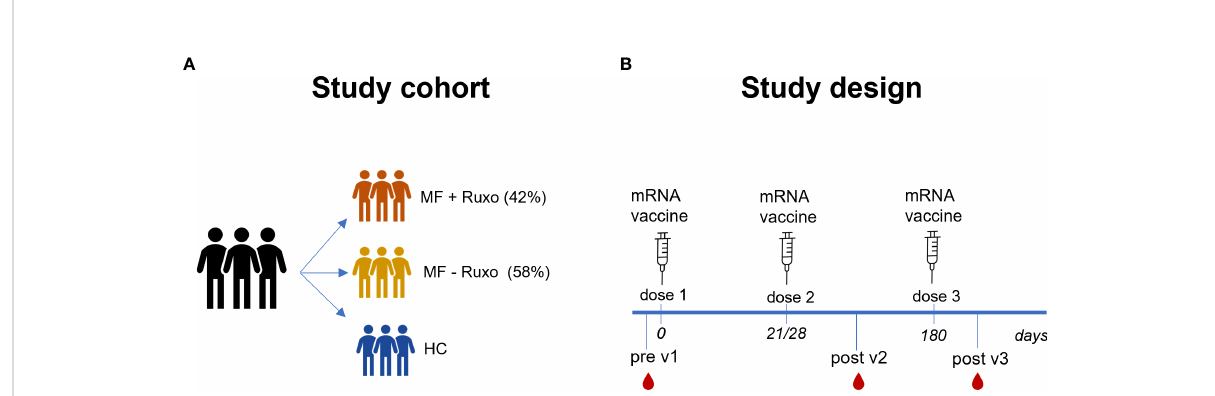
FIGURE 1 Schematic representation of the study cohort and design. (A) Patients with myelo fi brosis (MF), treated or not with ruxolitinib (Ruxo), and healthy controls (HC) were immunized with three doses of mRNA vaccines anti SARS-CoV-2. (B) Antibody and B-cell responses were evaluated at the baseline and after the second and the third vaccination dose.